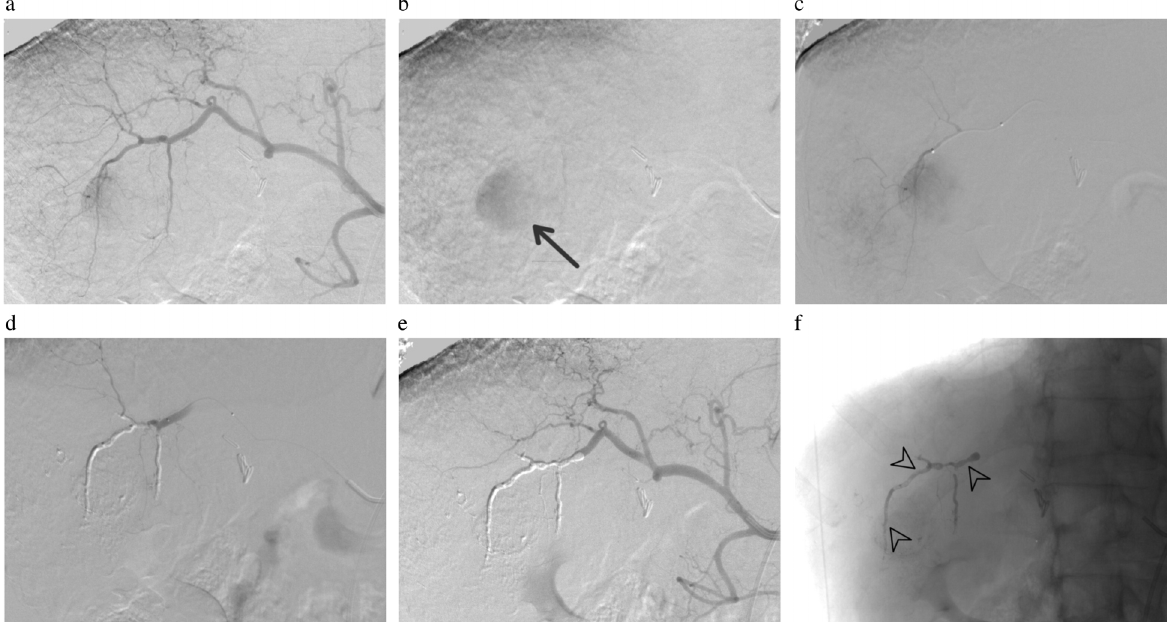
Figure 2 - a-f: NBCA-TACE standardization. Selective angiography of the common hepatic artery (a, b) depicts a hypervascular lesion nourished by distal branches of the hepatic artery (arrows). Microcatheters reached the supplying arteries of the tumor (c). After the third microcatheterization, with two prior occlusions of smaller distal branches via the application of NBCA-Lipiodol mixture, no staining of the tumor was seen (d). Application of the NBCA-Lipiodol mixture was performed to definitively occlude that branch and final angiography showed complete occlusion of the branches directed to the tumor (e). The NBCA-Lipiodol mixture cast inside the occluded branches is shown by arrowheads (f).